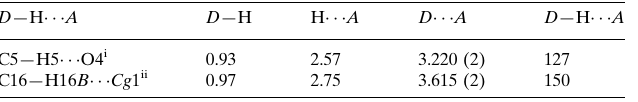
Hydrogen-bond geometry (A˚ , (cid:1) ). Cg 1 is the centroid of the C8–C13